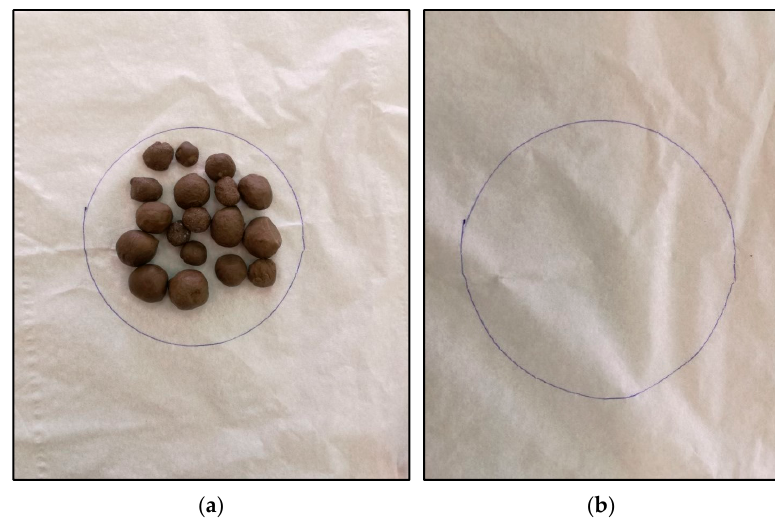
Figure 13. Exudation stability of GP-LECA-PCM. ( a ) Filter paper with GP-LECA-PCM; ( b ) Filter paper after removing GP-LECA-PCM.